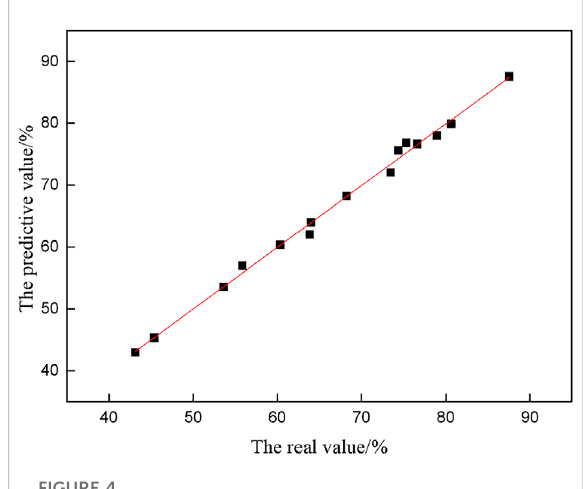
FIGURE 4 Comparison between predicted value and real value.